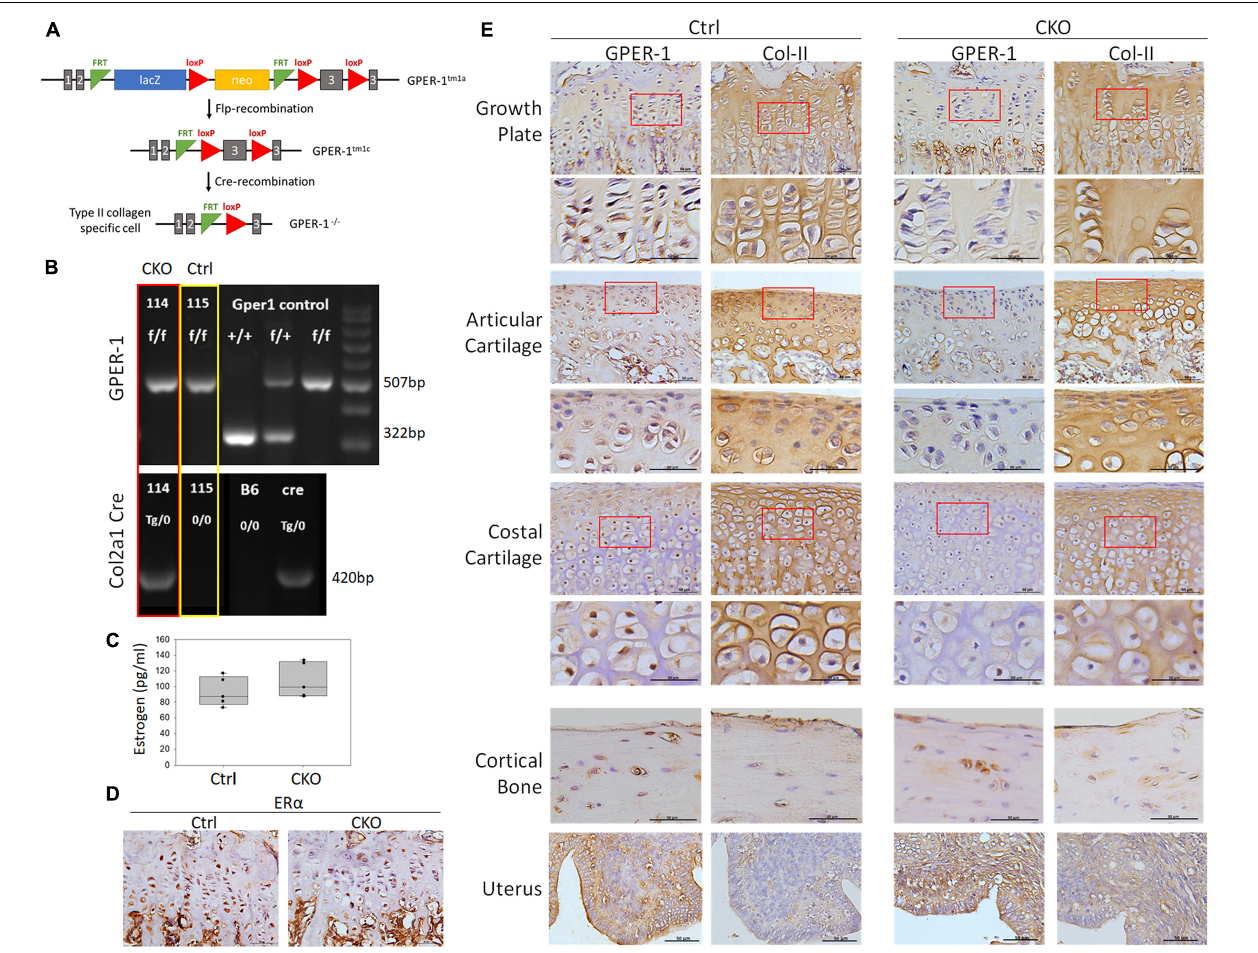
FIGURE 2 | Generation of chondrocyte-specific GPER-1 knockout (CKO) mice using Cre/loxP system. (A) Schematic diagram of producing Col2a1-Cre ; GPER-1 f / f mice. (B) Genotyping of Col2a1-Cre and GPER-1 in control (Ctrl) and CKO mice. Genotyping of GPER-1 floxed allele amplified a 507-bp fragment, whereas GPER-1 wild-type allele produced a 322-bp fragment. Col2a1-Cre transgene produced a 420-bp fragment. Each group, N = 28–34. (C) Serum levels of estrogen showed no significant difference with GPER-1 deficiency. (D) IHC staining of ER α in tibia growth plates showed no significant difference between two groups. Scale bars, 50 µ m. (E) GPER-1 and type II collagen (Col-II) were stained by IHC staining and analyzed in tibia growth plate, articular cartilage, costal cartilage, cortical bone, and uterus. Representative micrographs of growth plates at low and high magnification. Scale bars, 50 µ m. Each group, N =